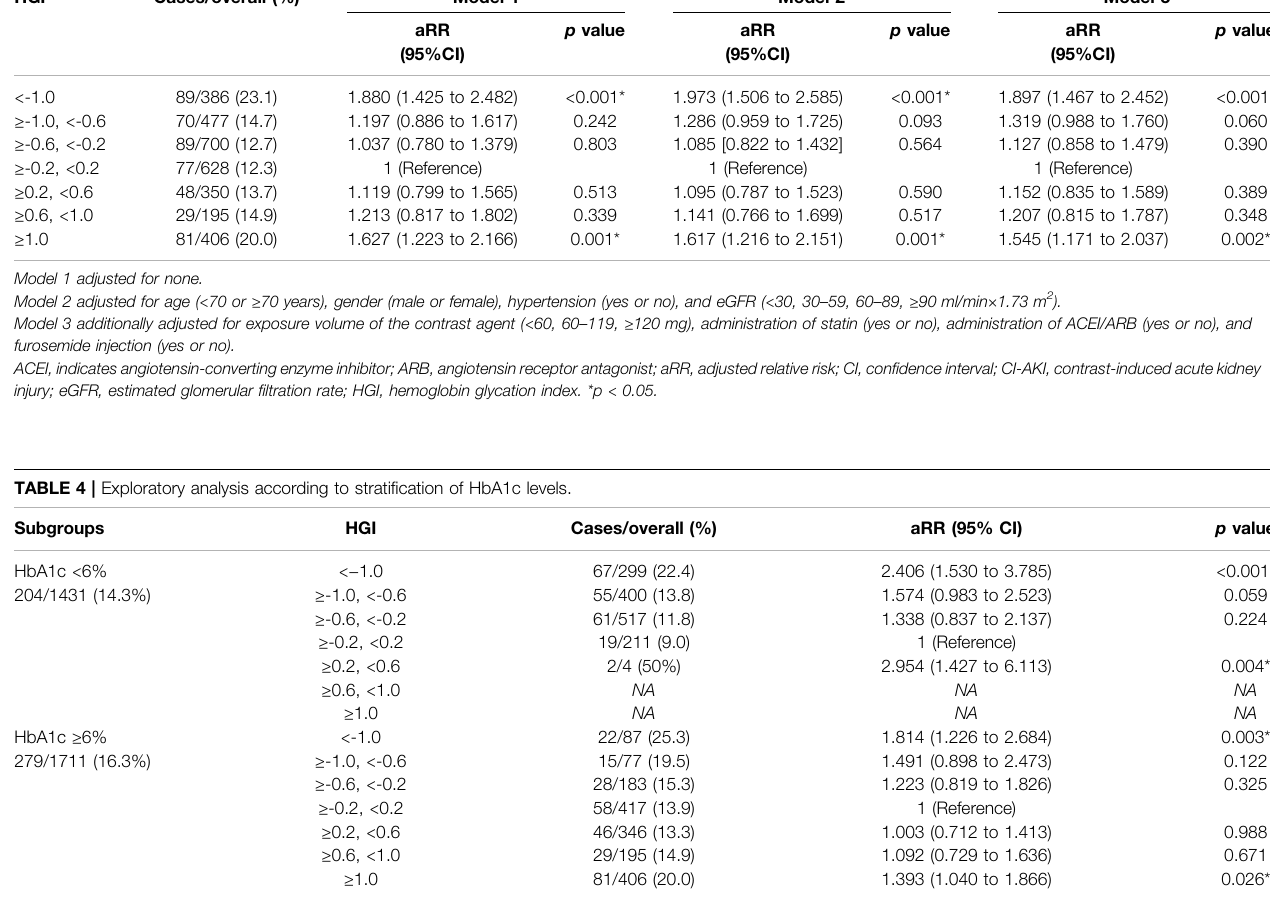
TABLE 3 | Modi fi ed Poisson ’ s regression analysis of HGI categories with CI-AKI. HGI Cases/overall (%)